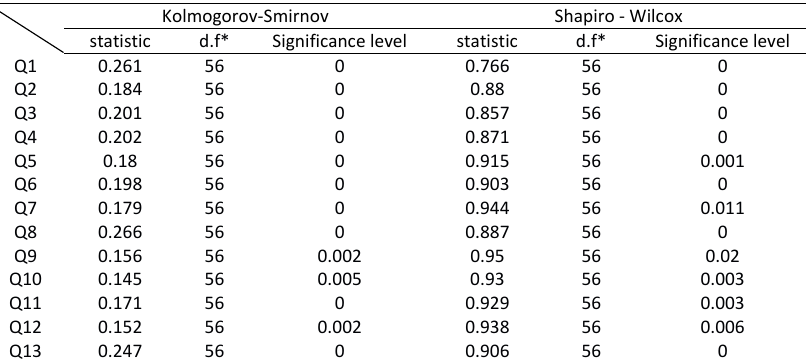
Table 5: Table of Normality of Variables Table 5. Table of Normality of Variables